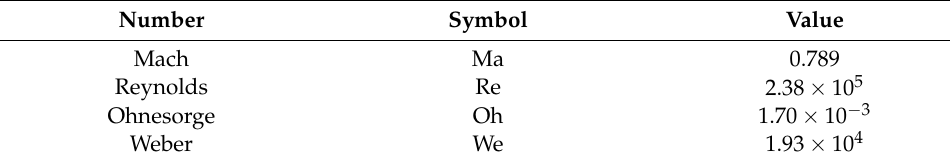
Table 3. Characteristic dimensionless